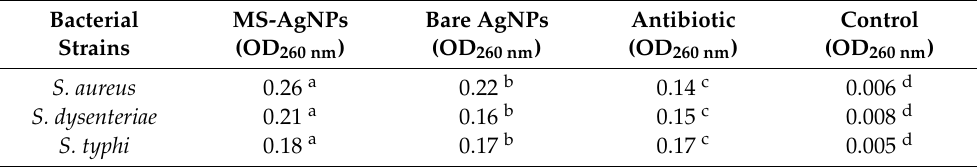
Table 2. OD at 260 nm of the cell constituent (nucleic acids) release from the selected bacterial strains upon treatment with MS-AgNPs, bare AgNPs, antibiotic, and control. Bacterial MS-AgNPs Bare AgNPs Antibiotic Control Strains (OD 260 nm ) (OD 260 nm ) (OD 260 nm ) (OD 260 nm )